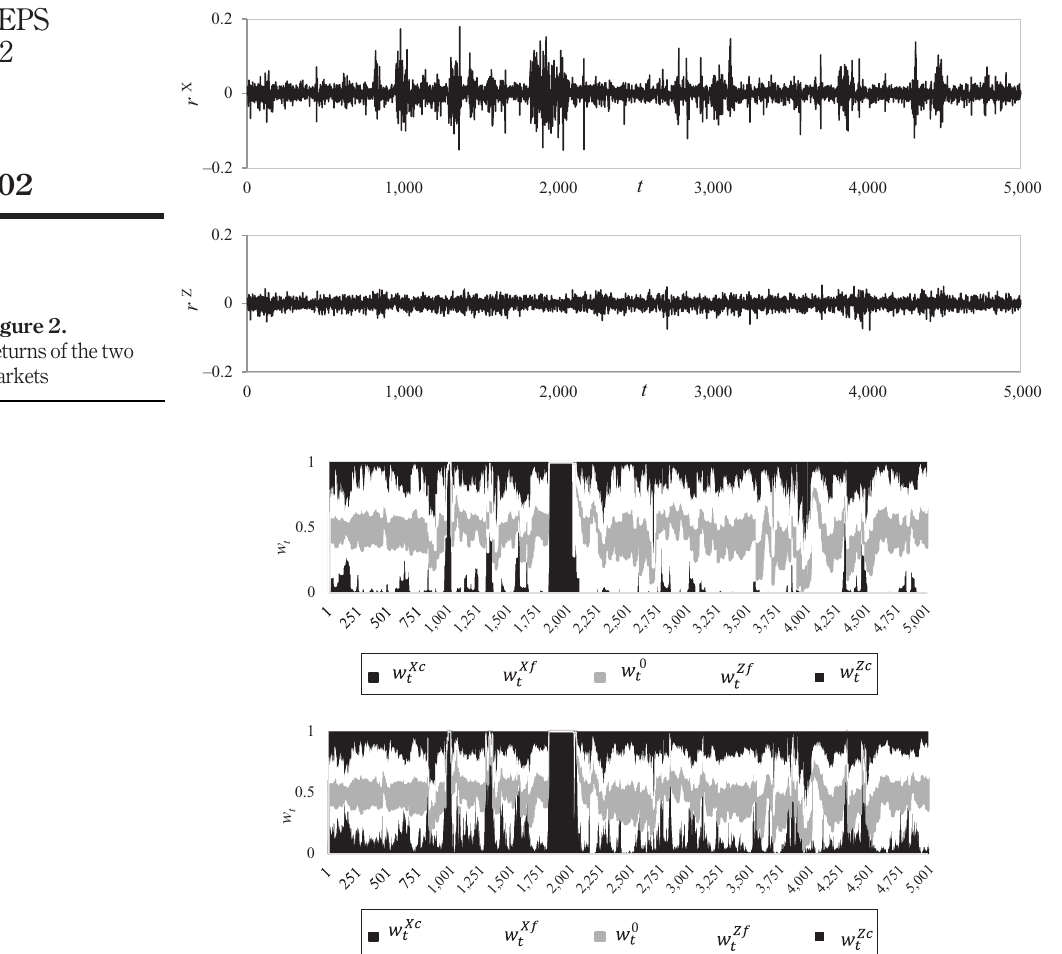
751 001 751 001 251 001 251 501 751 501 251 501 501 001 251 751 001 5 , 3 , 1 , 2 , 2 , 3 , 3 , 3 , 2 , 2 , 4 , 4 , 1 , 1 , 1 , 4 , 4 , 751 751 001 251 001 251 501 251 501 751 501 501 001 251 751 001 5 , 3 , 1 , 3 , 2 , 2 , 4 , 4 , 3 , 3 , 2 , 2 , 1 , 1 , 1 , 4 , 4 , 0 , w Xf , w 0 , w Zf and w Zc , respectively. Henceforth, t t t t t